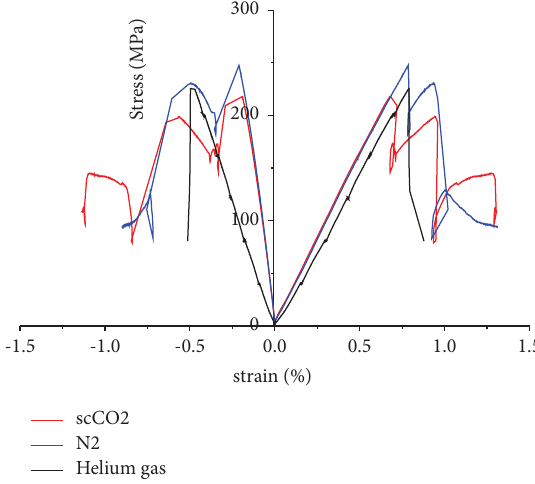
Figure 8: Stress-strain curves at the coring angle of 60 ° .